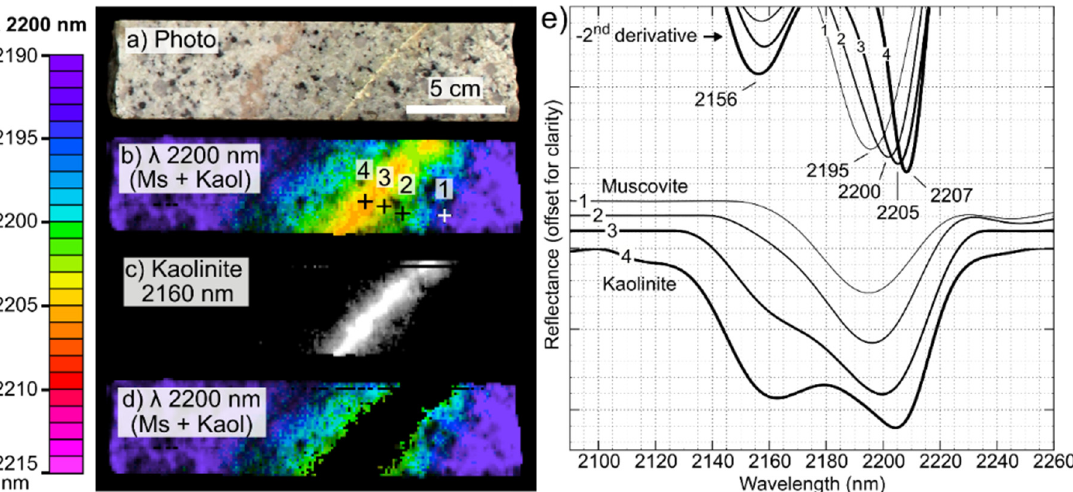
Figure 13. Drill core interval from core presented in Figure 9. ( a ) Core photograph. ( b ) Hyperspectral imagery processed to display the position of the 2200 nm absorption feature, not filtered by mineralogy and including interference from kaolinite. ( c ) Presence of kaolinite, derived from the presence of an absorption near 2160 nm. ( d ) Image presented in a), with masking of the pixels showing 2160 nm absorption. ( e ) Detail of continuum removed and second derivative spectra extracted from the approximate 3 × 3 pixels area indicated in ( b ).